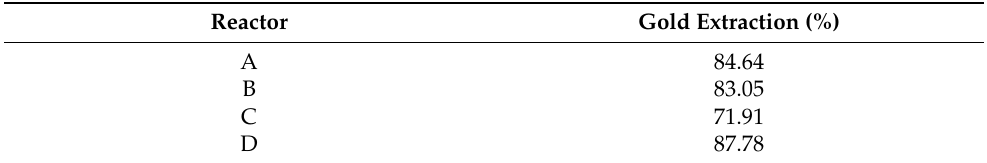
Table 7. Extraction of gold from residues of the pyrite oxidation experiment with reactors A–D using 3.75 kg NaCN t − 1 .